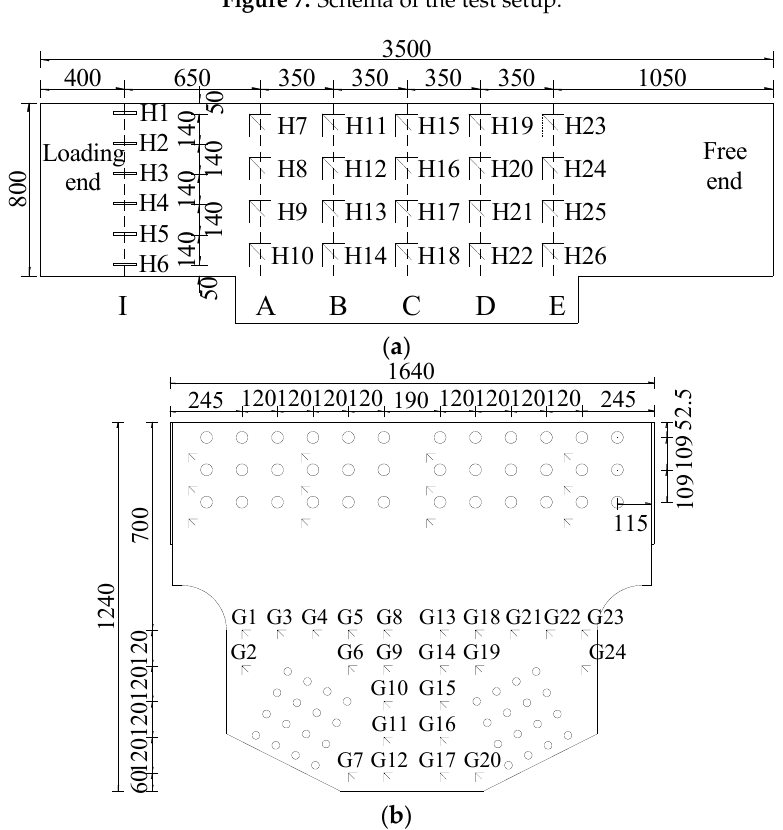
Figure8. Arrangement of strain gauges and rosettes (unit: mm). ( a ) the concrete chord. ( b ) the gusset plate.